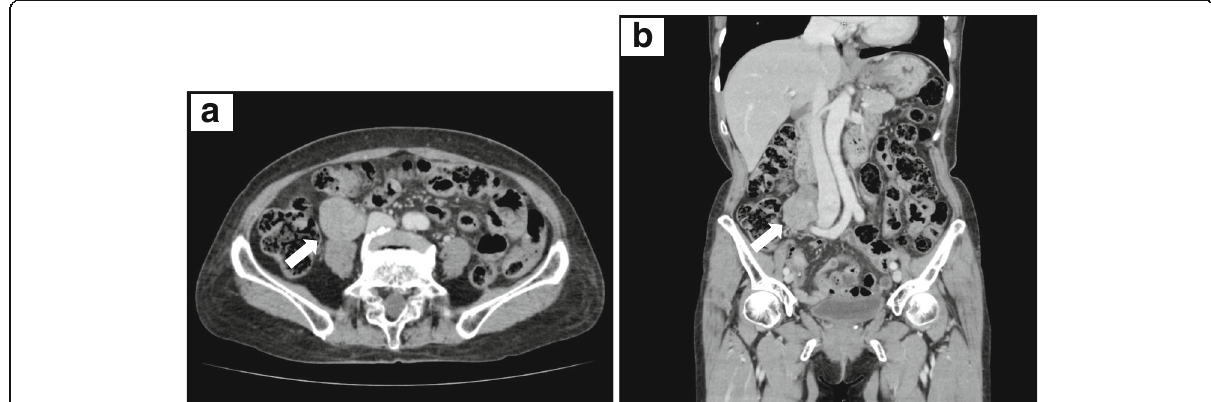
Fig. 1 Contrast-enhanced computed tomography of the leiomyosarcoma. Axial ( a ) and coronal ( b ) contrast-enhanced computed tomography of the patient ’ s abdomen revealing a well-defined, lobulated solid mass (white arrows) with a diameter of 5.5 cm in the right retroperitoneal space